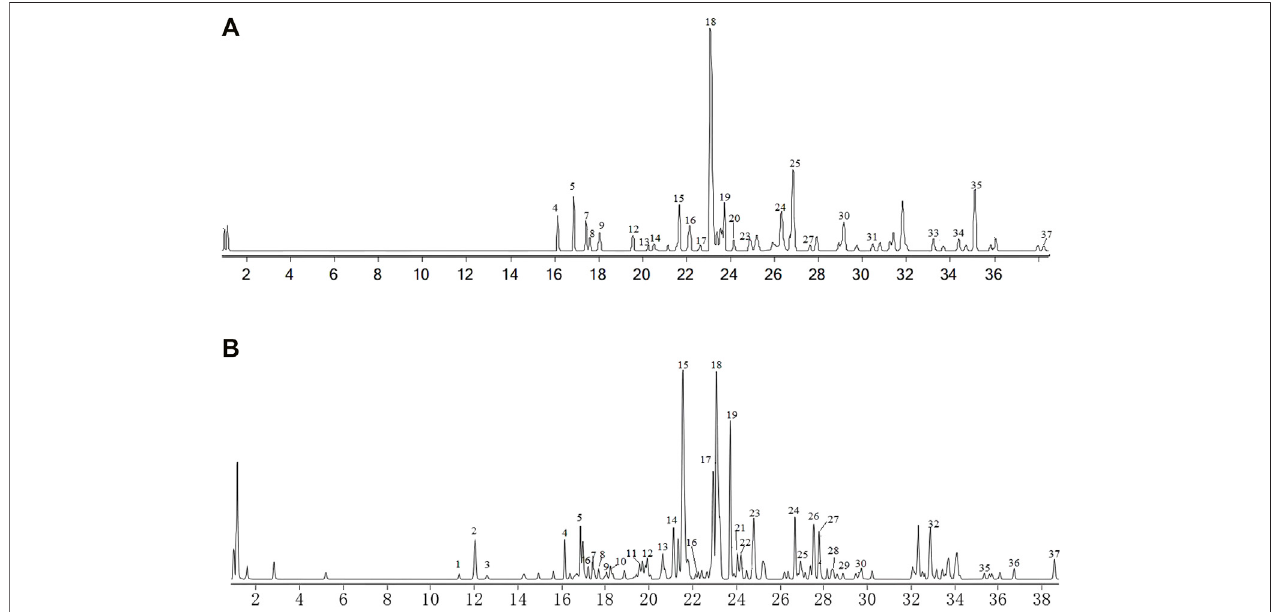
FIGURE4| Totalionchromatograms(TIC)fromXHP. (A) TIC(+ESITCC)ofXHP. (B) TIC(-ESITCC)ofXHP. Figure1 Totalionchromatograms(TIC)fromXHP. (A) TIC (+ESI TCC) of XHP. (B) TIC (-ESI TCC) of XHP.